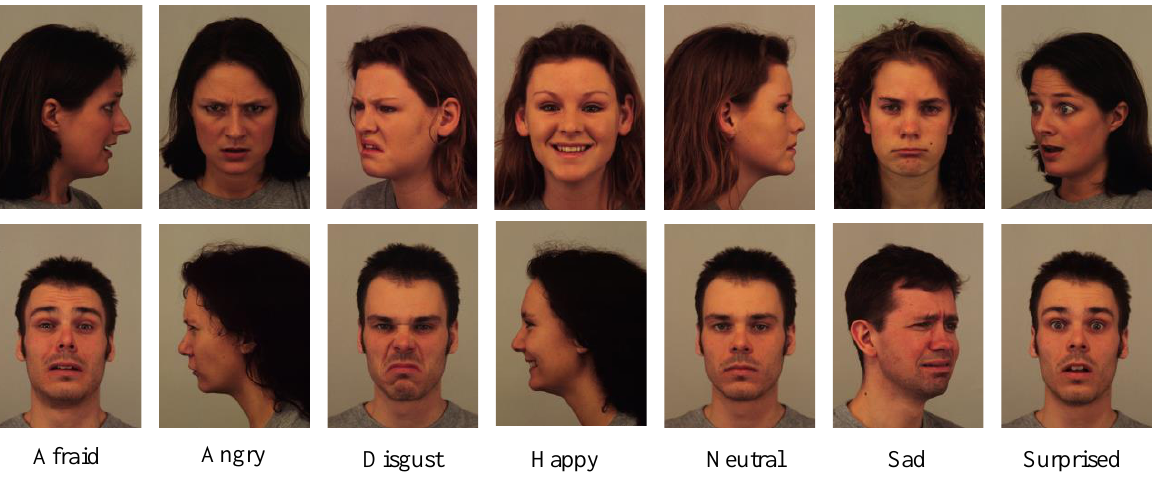
Figure 5. Sample images from KDEF dataset.